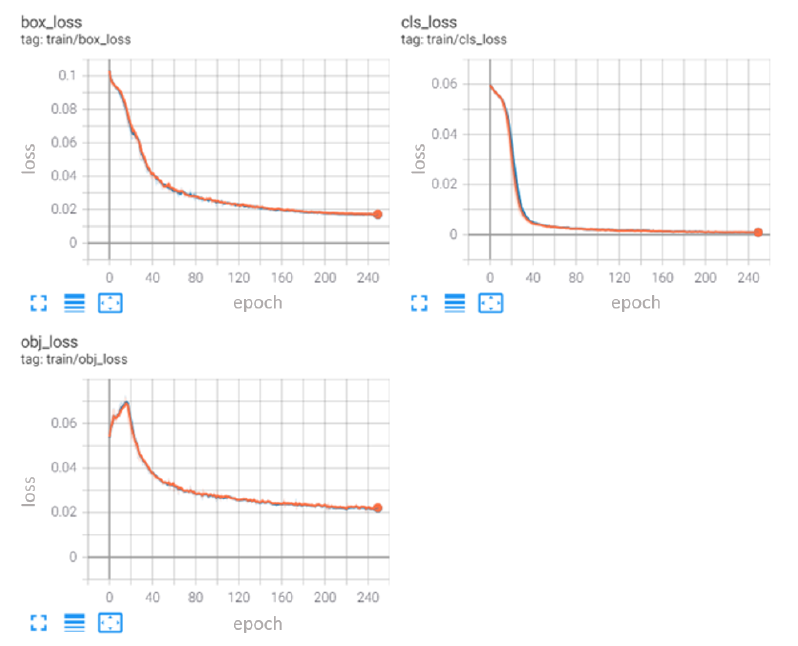
Figure 7. Loss functions for both the models YOLOv5s (blue) and YOLOv5m (orange).